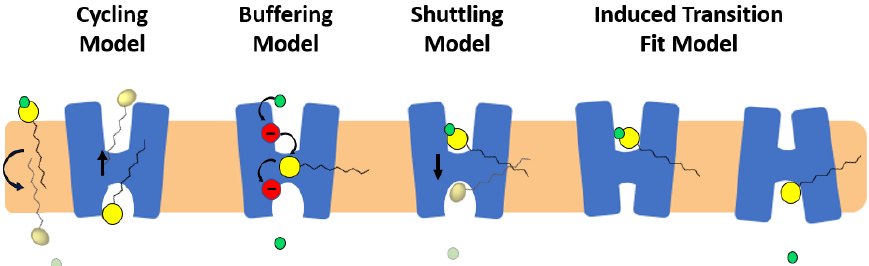
Figure 5. Proposed mechanisms of proton transport in UCPs. In the fatty acid cycling model, protonated fatty acid (yellow head group and a black tail) flip-flops across the lipid bilayer, releases its proton (green circle) and is transported from to the IMS as an anion by UCP. In the buffering model, fatty acid anion binds to UCP and accepts/donates protons via its carboxylate group from and to titratable amino acids of the translocon channel. In the shuttling model long chain fatty acids remain bound to the protein while their head moves back and forth across the IMM (getting protonated in the IMS and releasing the proton into the matrix). In the ITF, UCP changes conformation from cytoplasmic to matrix state and vice versa upon movement of fatty acid across the translocon channel.